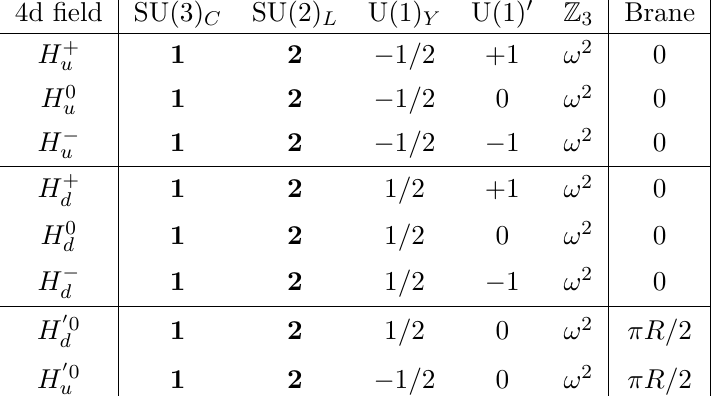
Table 3 . Higgs fields located at the different branes. The H − renamed as H u,d (see discussion in the main text).